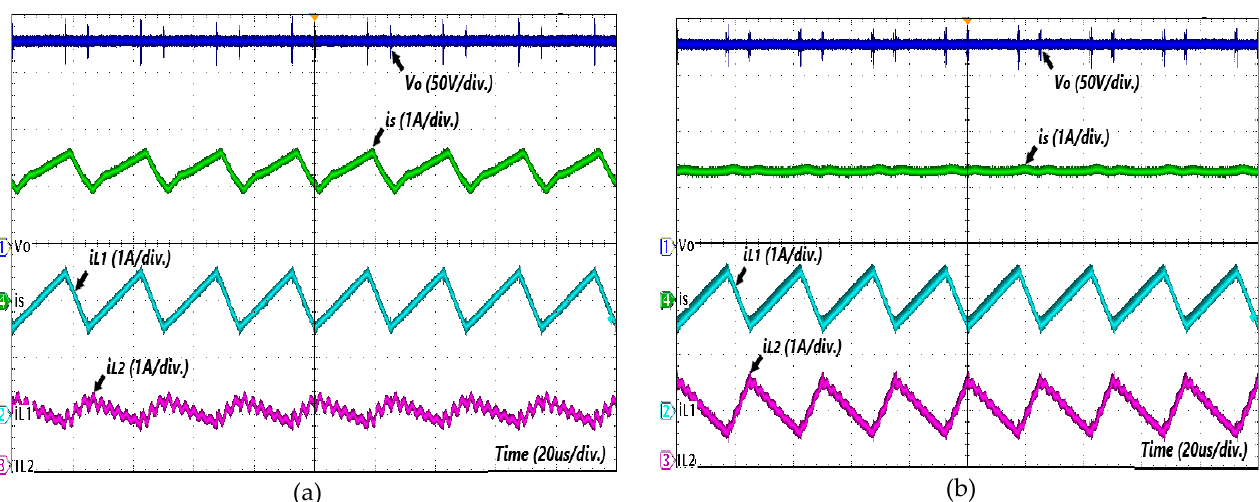
Figure 12. Waveforms of currents/voltage of open loop tests: ( a ) ICR presence at d = 0.7; ( b ) zero- ripple input current at d = 0.7.